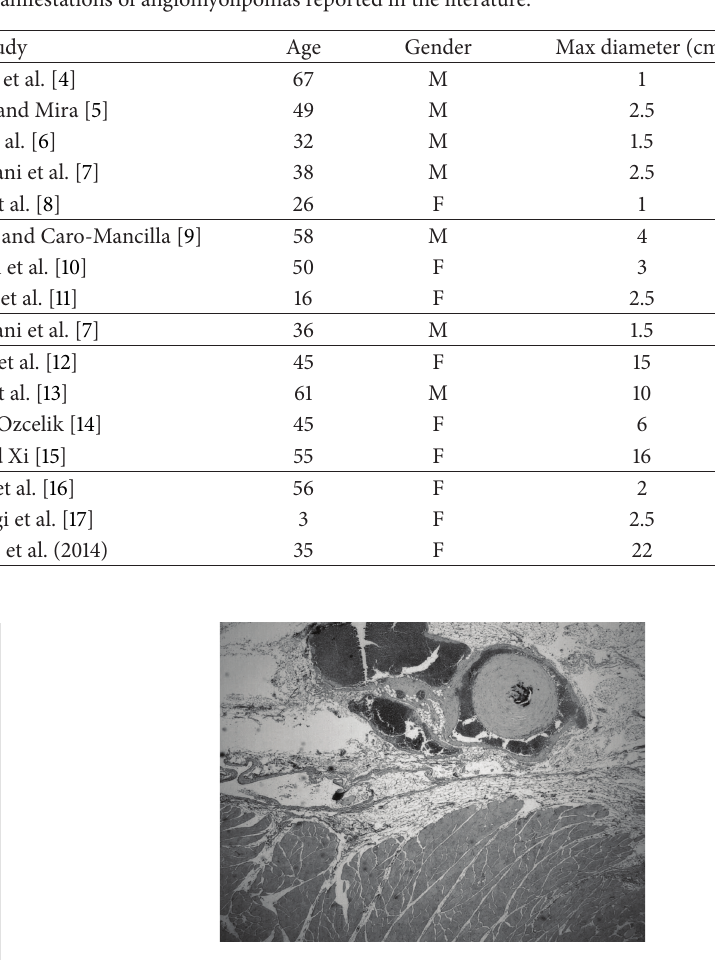
Figure 2: H-E staining (10x) that highlights the three distinct components of the angiomyolipoma: thick-walled blood vessels, mature adipose tissue, and interlacing smooth muscle